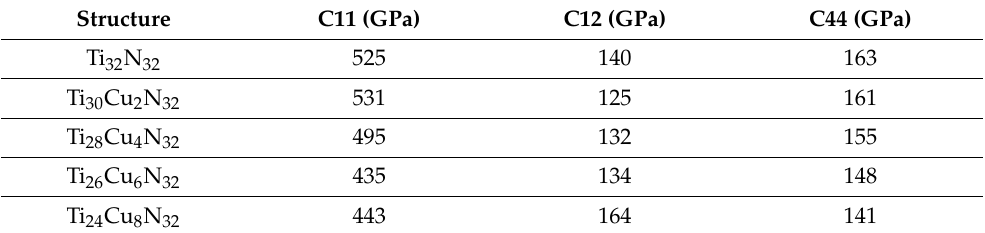
Table 4. Elastic coefficients of TiCuN with different Cu contents.